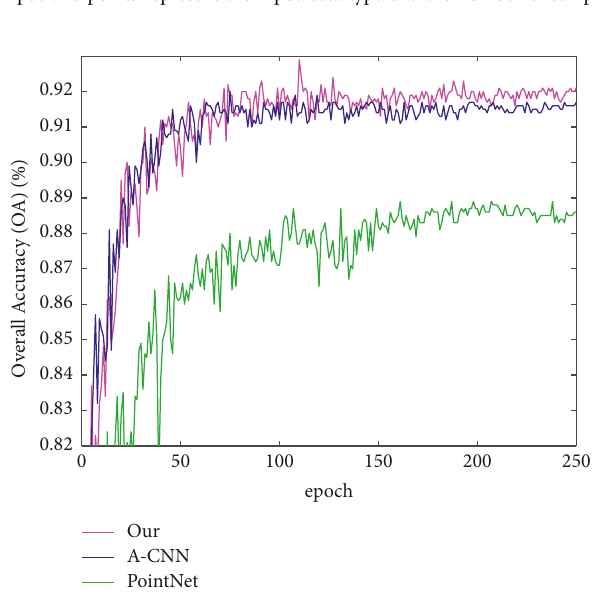
Figure 4: Variation of the overall accuracy (OA) in % on Mod- elNet40 with 250 epochs.